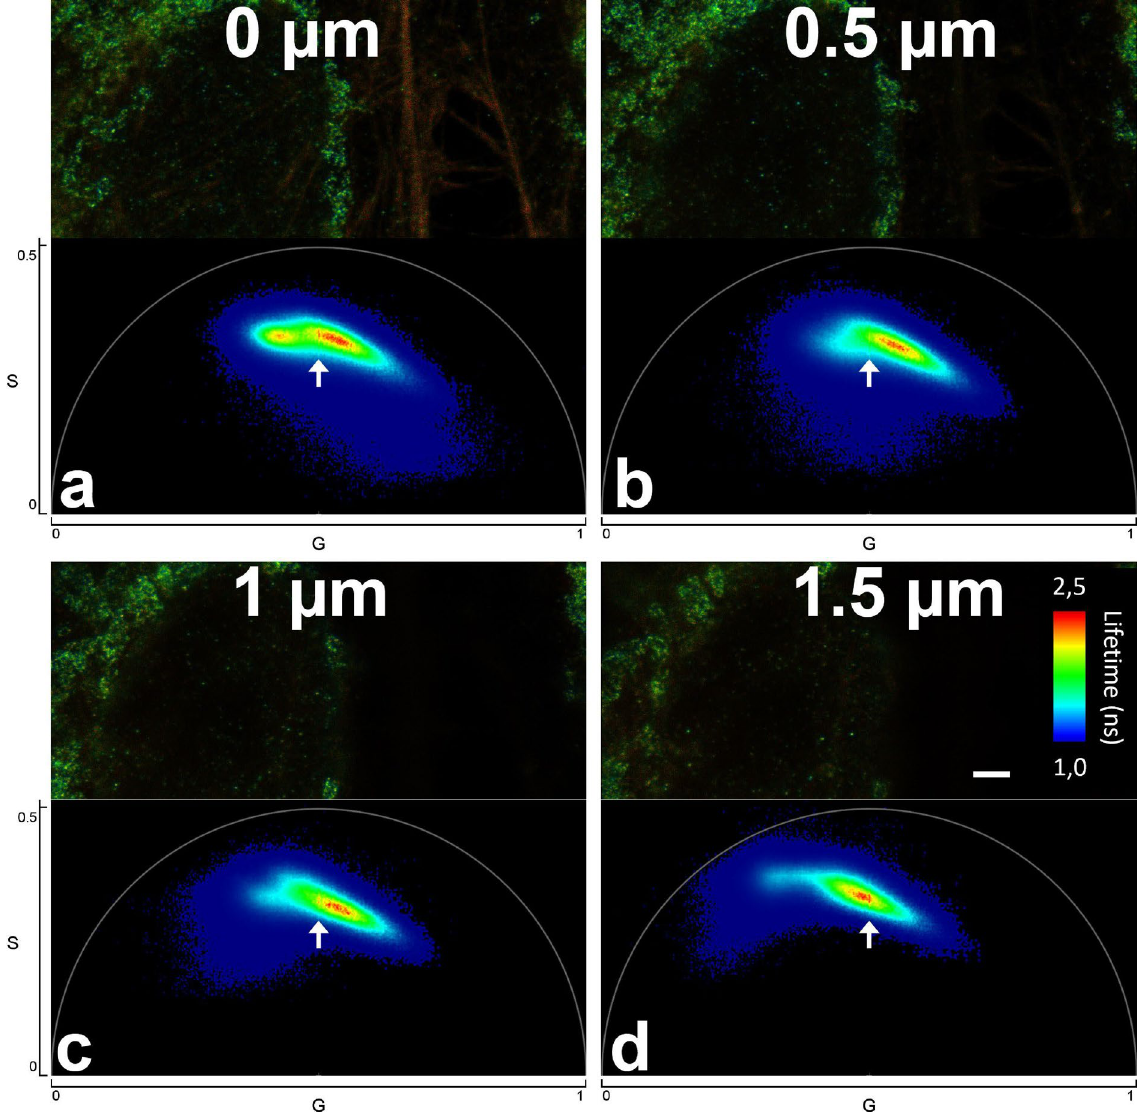
Figure 6. Fluorescence lifetime changes with distance to the coverslip. Parts of raw images of the far red channel from a five color sample at different sample depths (scale bar 2 µm) and their respective phasor plots. The color in the microscopic images codes the average lifetime of the pixels. ( a ) is near to the coverslip, ( b – d ) each 0.5 µm further into the sample. The arrows over the phasor plots always point to the same position. Near the coverslip in ( a ), ATTO 647N labeled phalloidin produces a separate peak to the left in phasor plot that dwindles further into the sample due to the reduced amount of actin at higher sample depths. Note the movement of the Abberior STAR 635P contribution in the phasor plot (major peak) relative to the